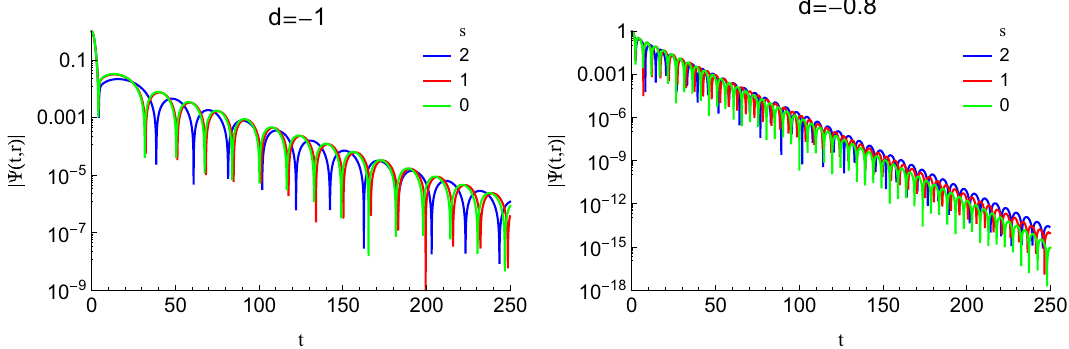
Fig. 2 Thisfigureevaluatedat r = 2 for (cid:16) = 2, b = − 0 . 1,and c = 0 . 3 . It shows the QN modes of scalar ( s = 0) and electromagnetic ( s = 1) perturbations alongside the gravitational ones ( s = 2). By comparing